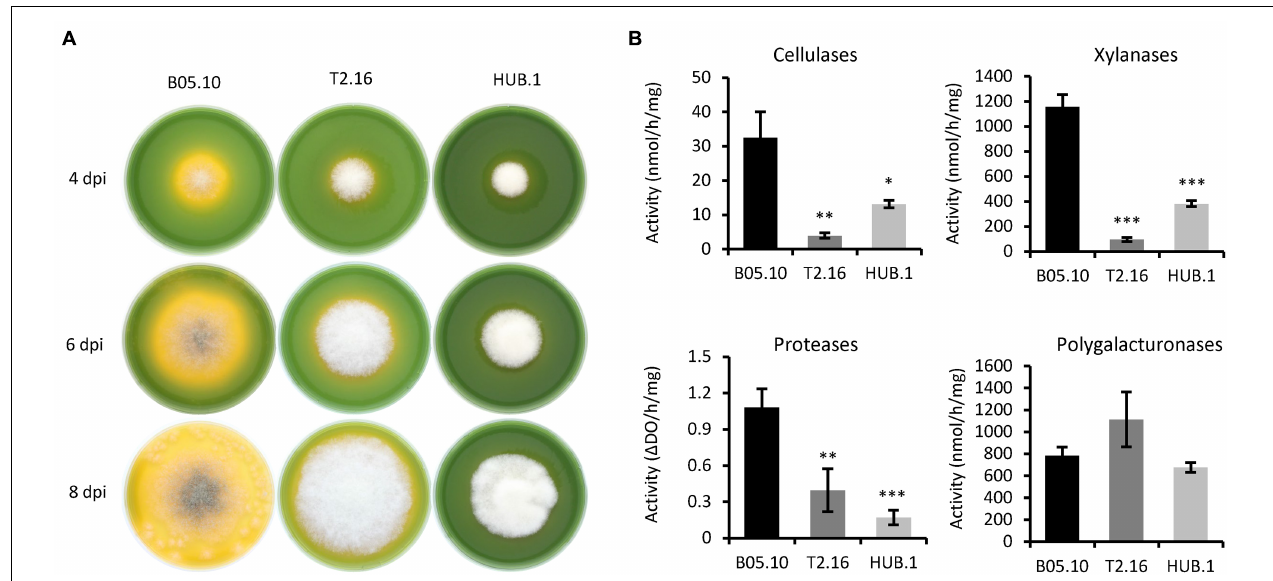
FIGURE 3 | Enzymatic activities and medium acidification in the clathrin mutants. (A) Medium acidification. Agar plugs of parental (B05.10) and mutant (T2.16 and HUB.1) mycelia were used to inoculate solid complete medium adjusted to pH 8.0 and supplemented with 0.01% bromothymol blue (yellow at pH < 6.0). Acidification of the medium was monitored at 4, 6, and 8 days post-inoculation. Photos are representative of three independent experiments. (B) Enzymatic activities measured in the supernatants of liquid cultures in CCPX medium at 72 h post-inoculation for the parental (B05.10) and mutant (T2.16 and HUB.1) strains. Activities are expressed in nmole or (cid:49) DO per hour per mg of mycelium. Three independent biological replicates were performed. Means with standard deviations are indicated, and asterisks indicate significant difference compared to the B05.10 strain (Student’s t -test p -value ∗ < 0.05; ∗∗ < 0.01; ∗∗∗ <